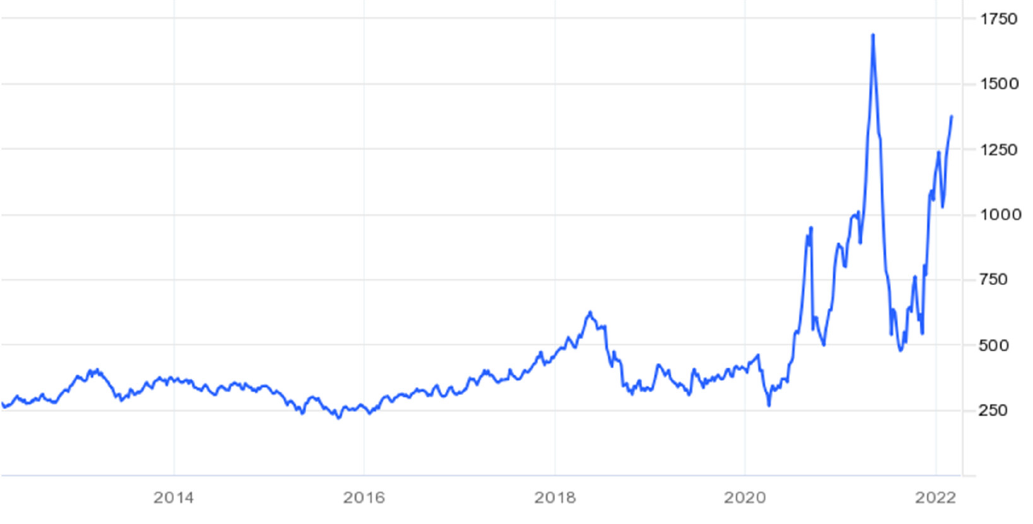
Figure 11. Lumber prices [USD] in U.S. over last decade [73].